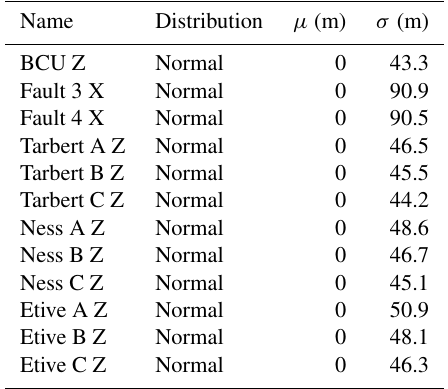
Table 2. Distribution parameters for prior parameterization of the Gullfaks case